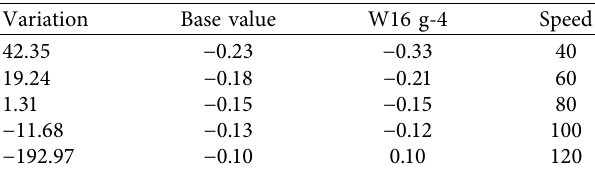
different wind speeds.